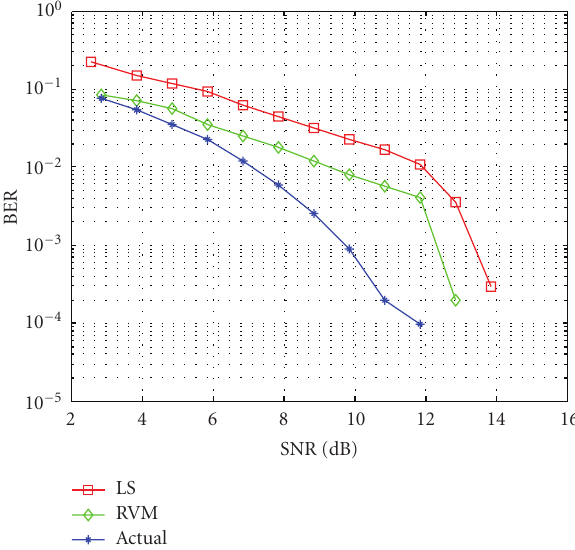
Figure 6: BER curves versus SNR with equalization at